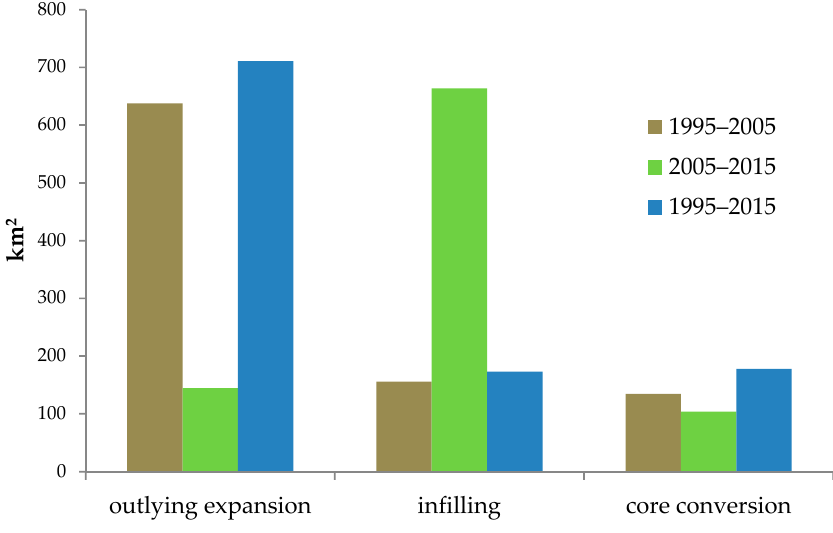
Figure 11. Areas of different change types (1995–2015).